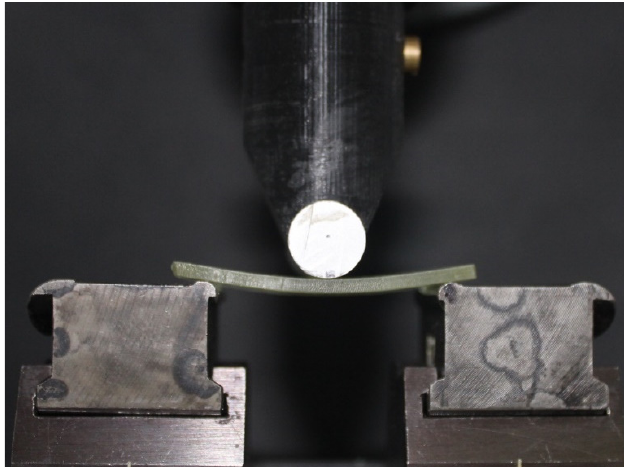
Figure 2. 3-point bending test of a specimen from group 3.